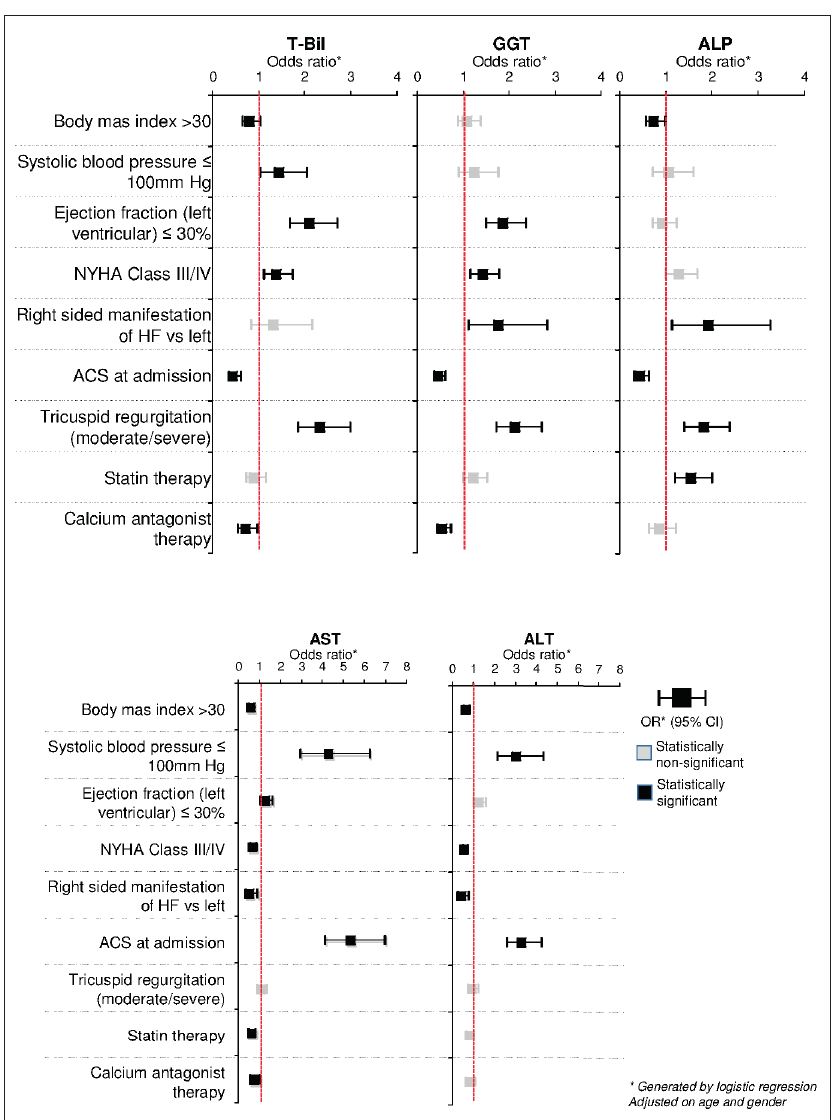
Fig. 3. Multivariate analysis of factors predicting abnormal